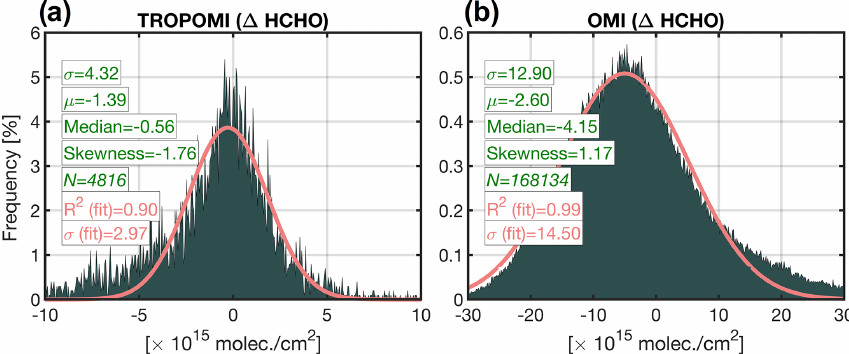
Figure 11. The histogram of the differences between TROPOMI and OMI and benchmarks. FTIR and corrected GEOS-Chem simulations are the TROPOMI and OMI benchmarks. The data curation and relevant criteria on how they have been paired can be found in Vigouroux et al. (2021) and Zhu et al. (2020). The statistics in green color are based on all data, whereas those in pink are based on the fitted Gaussian function.